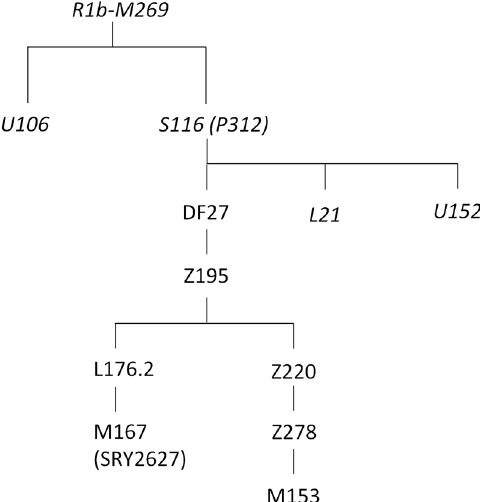
Figure 1. Simplified phylogenetic tree of the R1b-M269 haplogroup. SNPs in italics were not analyzed in this